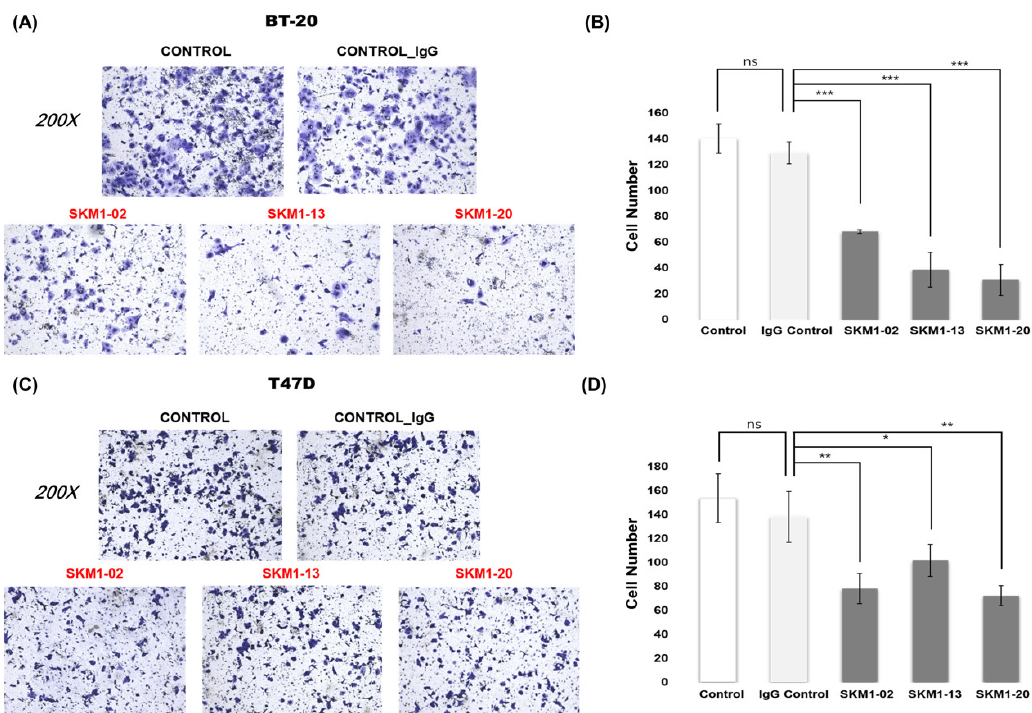
Figure 6. E ff ect of MUC1-C targeting antibodies on metastatic activity. To analyze the anti-metastatic function of selected antibodies, in vitro Matrigel invasion assays of BT-20 and T47D cells were performed. ( A , C ) Representative images for Matrigel invasion assay for the antibody treatments on BT-20 and T47D cells. After BT-20 and T47D cells were incubated for 48 h with 10 µ g / mL anti-MUC1-C antibodies and IgG control, the cells migrated to the lower chamber were fixed, stained with crystal violet, and counted using inverted microscopy(magnification 200 × ). Random fields were scanned (three fields per filter of the well) for accurate measurements. ( B , D ) The average number of total cells that migrated to the lower chamber per field of view in three independent experiments for BT-20 and T47D cells were plotted. ns: not significant ( p > 0.05), * p ≤ 0.05, ** p ≤ 0.01, *** p ≤ 0.001.